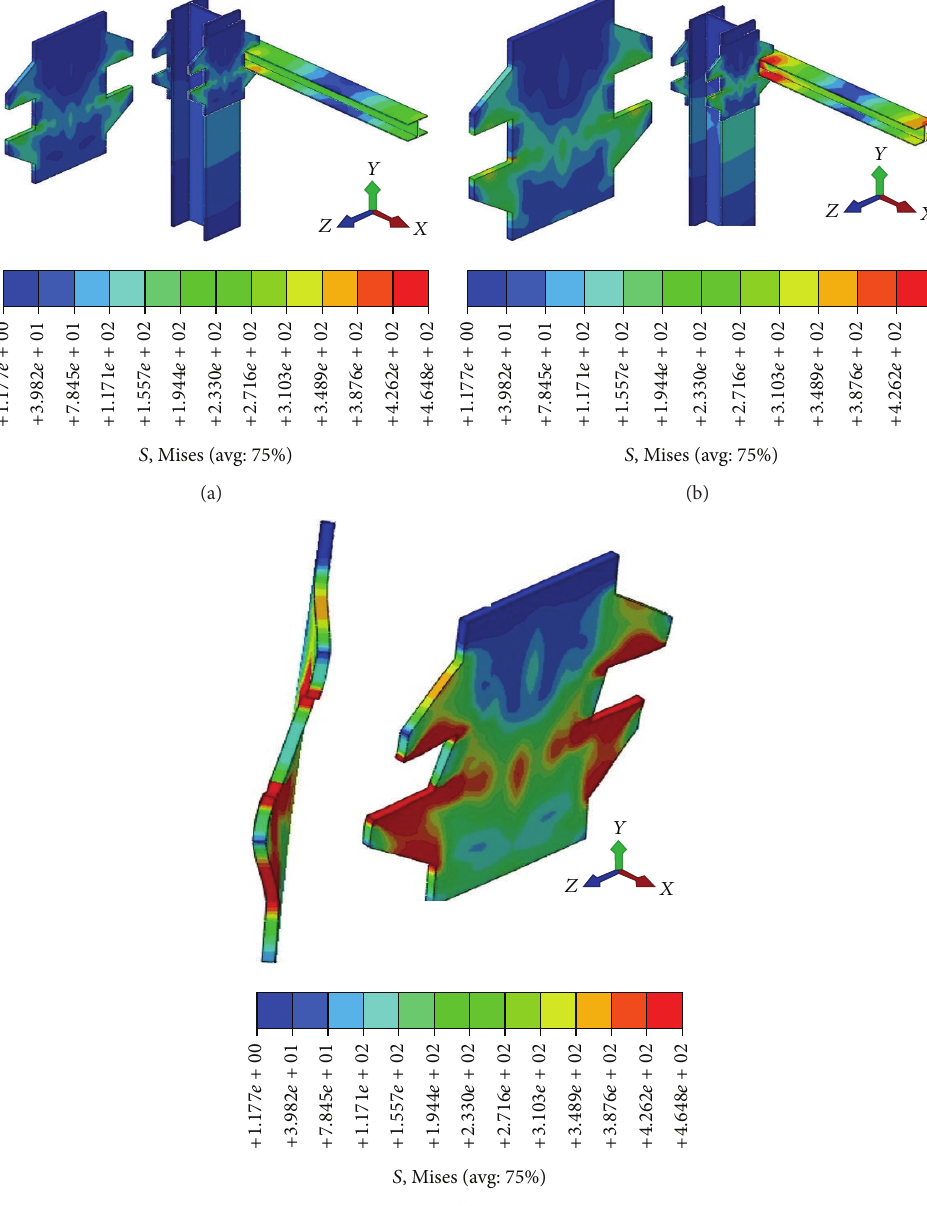
Figure 15: Saddlebag connection behaviour at the end of cyclic test.